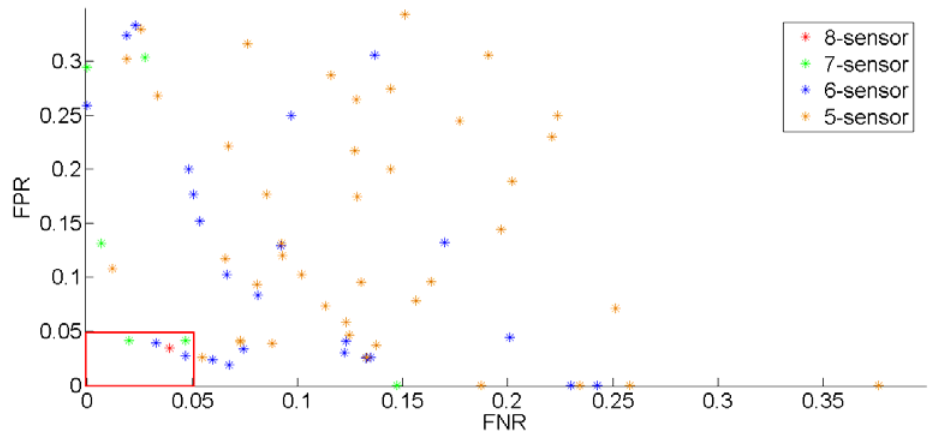
Figure 7. The result for different sensor deployment.